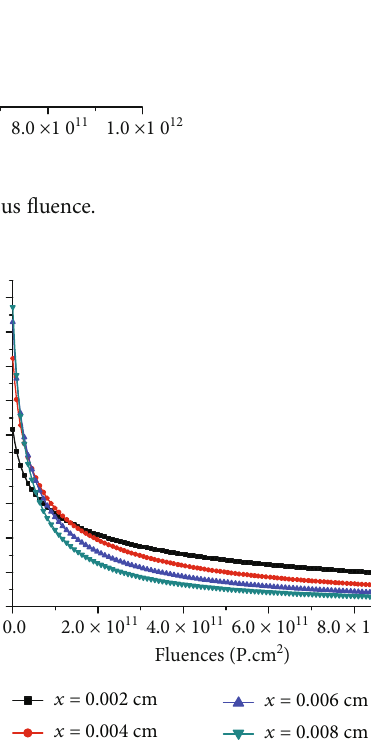
Figure 3: Carrier density versus particle ’ s fl ux at various position = 0 : 02 cm ; Sb = 4 : 10 4 cm : s − 1 ; Sf = 8 : 10 8 cm : s − 1 ; x in the base ( L 0 D = 27cm 2 : s − 1 ; H = 0 : 03 cm ; Kl = 5 : 6 : 10 − 7 ). n